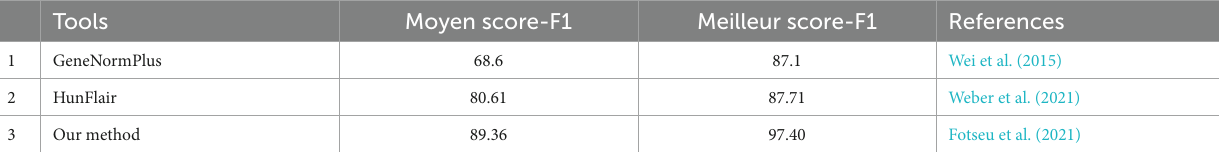
TABLE 2 Comparative F1-score (Moyen and Meilleur) for machine learning based models.